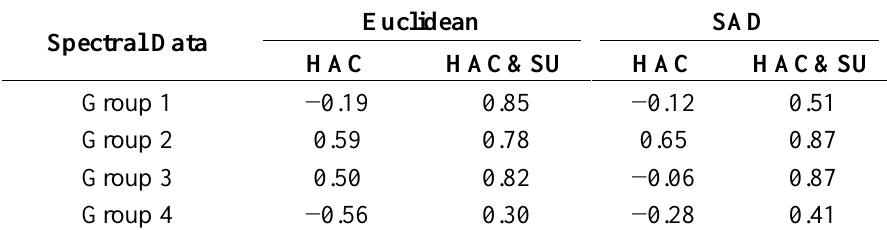
Table 2. Entropy correlation between field data and proposed method.